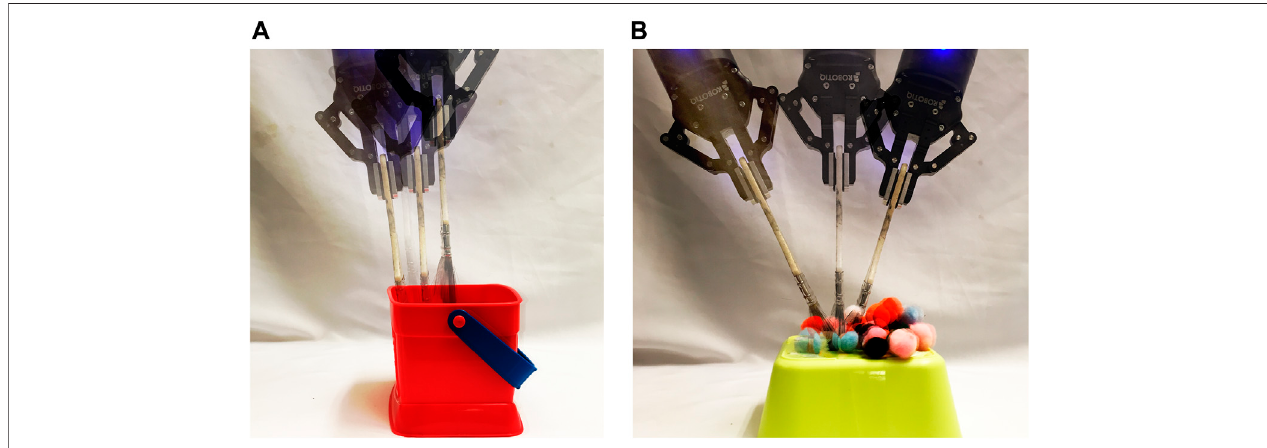
FIGURE7| Posesmeetingthesameorientationconstraintsharesimilarorientationsbutvarymoreintheirposition (A) ,whereasposesmeetingthesamecenter-of- rotation constraint rotate around the tooltip (B) .